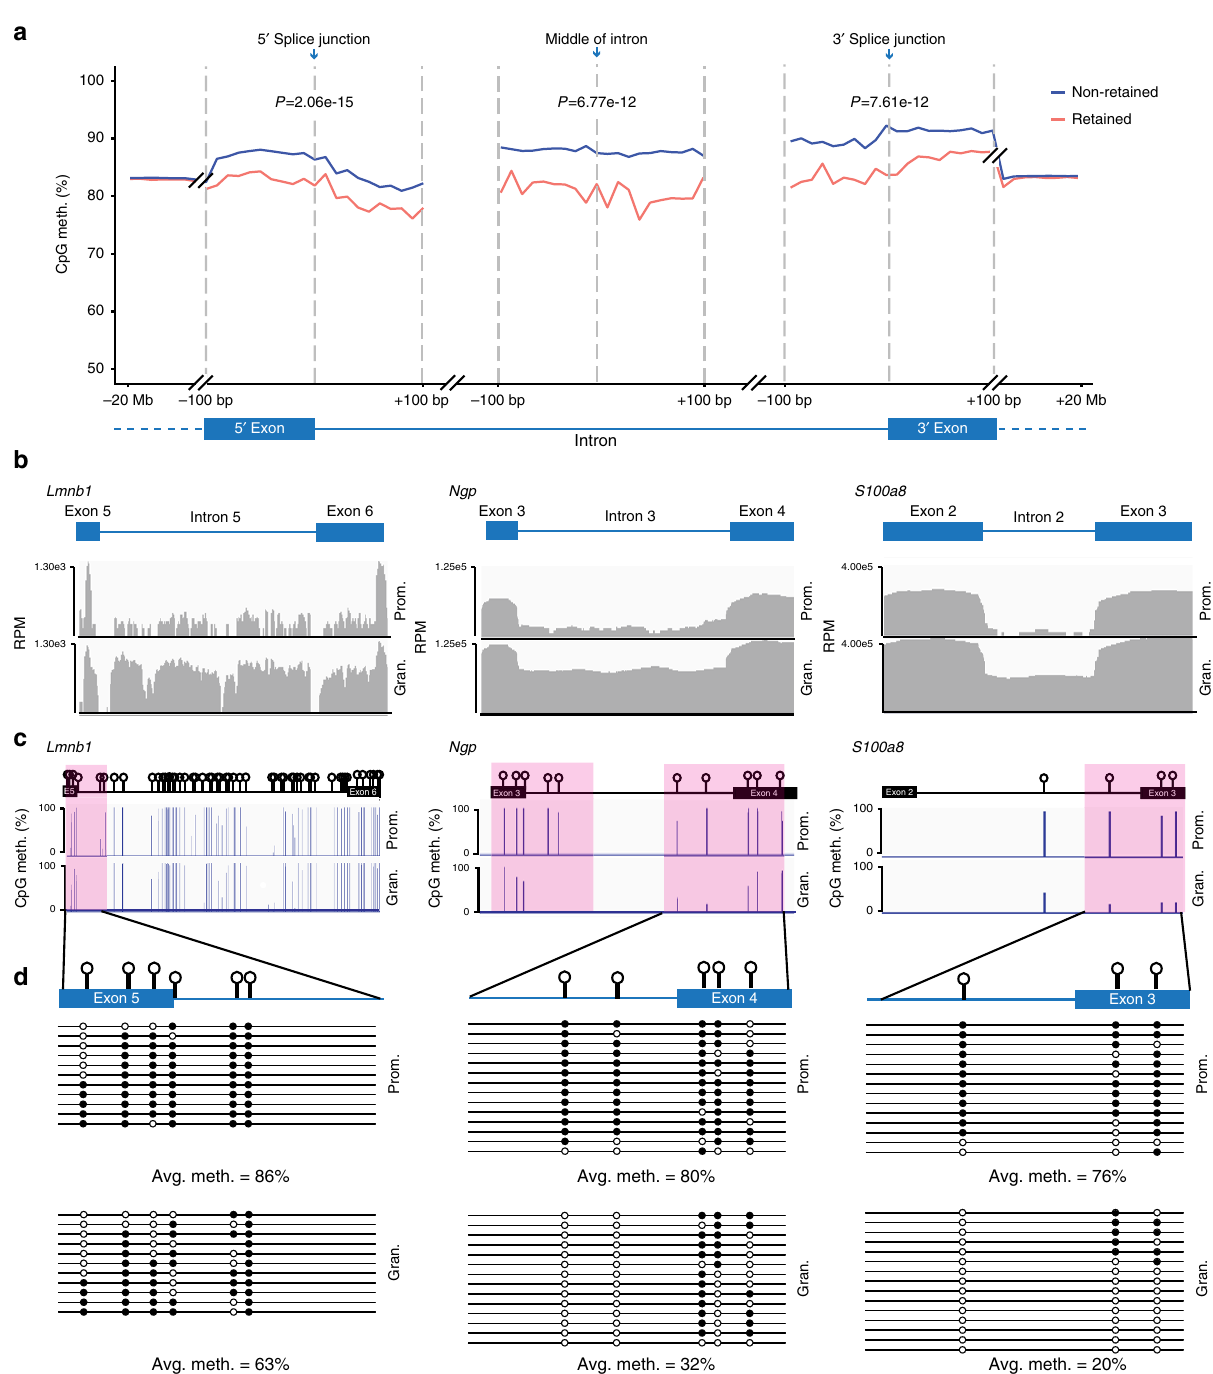
Figure 1 | IR in myeloid cells is associated with lower DNA methylation levels near splice junctions and within retained introns. ( a ) Average CpG methylation (CpG meth.) levels spanning ± 100bp from the 5 0 and 3 0 splice junctions, and from the middle of introns, in the DNA encoding non-retained (blue) and retained (red) introns in promyelocytes and granulocytes combined. Data were extended to (cid:2) 20Mb and þ 20Mb from the 5 0 and 3 0 splice junction respectively. t -test was used to determine significance at P o 0.05. ( b ) Examples from the IGVgenome browser comparing IR levels in Lmnb1 intron 5, Ngp intron 3 and S100a8 intron 2 in promyelocytes (Prom.) and granulocytes (Gran.). ( c ) Average DNA methylation level at each CpG across Lmnb1 intron 5, Ngp intron 3 and S100a8 intron 2 and their flanking exons in promyelocytes and granulocytes as assessed using whole-genome bisulfite sequencing. A ± 100bp region from each splice junction, with reduced DNA methylation in granulocytes, is shaded in pink. ( d ) Confirmation of the results in c using clonal bisulfite sequencing. Each row represents a single-cloned PCR amplicon aligned to the exon–intron map shown above. Lollipops on exon–intron map indicate positions of CpG sites. Circles denote methylated (black) and unmethylated (white) CpGs. NS, not significant; Avg. meth., average DNA methylation